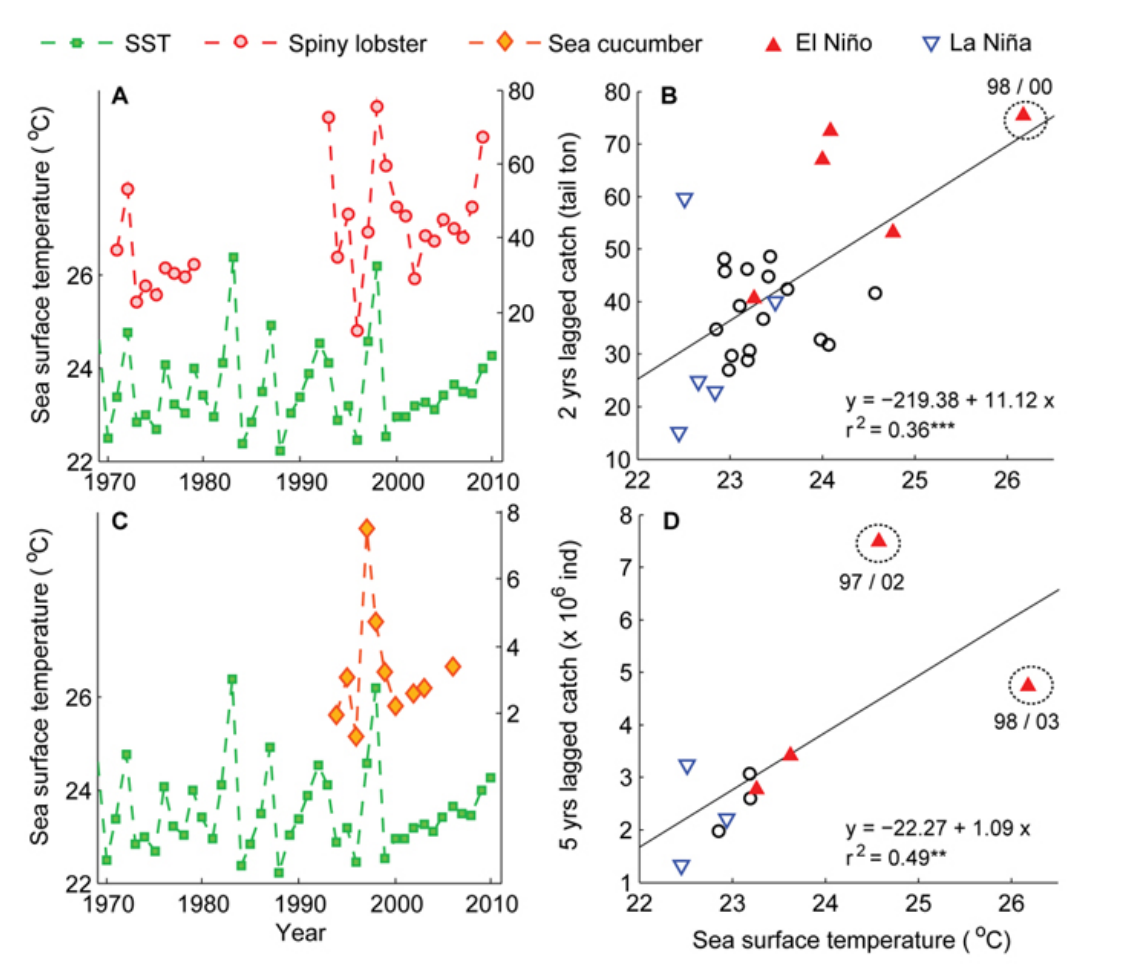
Fig. 3 . Time series and linear regressions between mean annual sea surface temperature (SST in situ, Santa Cruz Island) and lagged annual catch of spiny lobster ( Panulirus penicillatus and P. gracilis ; A, B) and sea cucumber ( Isostichopus fuscus ; C, D) in the Galápagos Islands, Ecuador. Catch series from 1995 to 2011 were linearly detrended and the residuals added to the mean, to account for the effect of fishing. Encircled triangles in B and D indicate the positive effect of 1997/1998 El Niño over spiny lobster (2000) and sea cucumber (2002–2003) catches. El Niño and La Niña events were defined based on the Oceanic Niño Index (ONI) estimated by the National Oceanic and Atmospheric Administration (NOAA). **: P < 0.05; ***: P < 0.001. Catch and SST time series were provided by Galápagos National Park and Charles Darwin Foundation